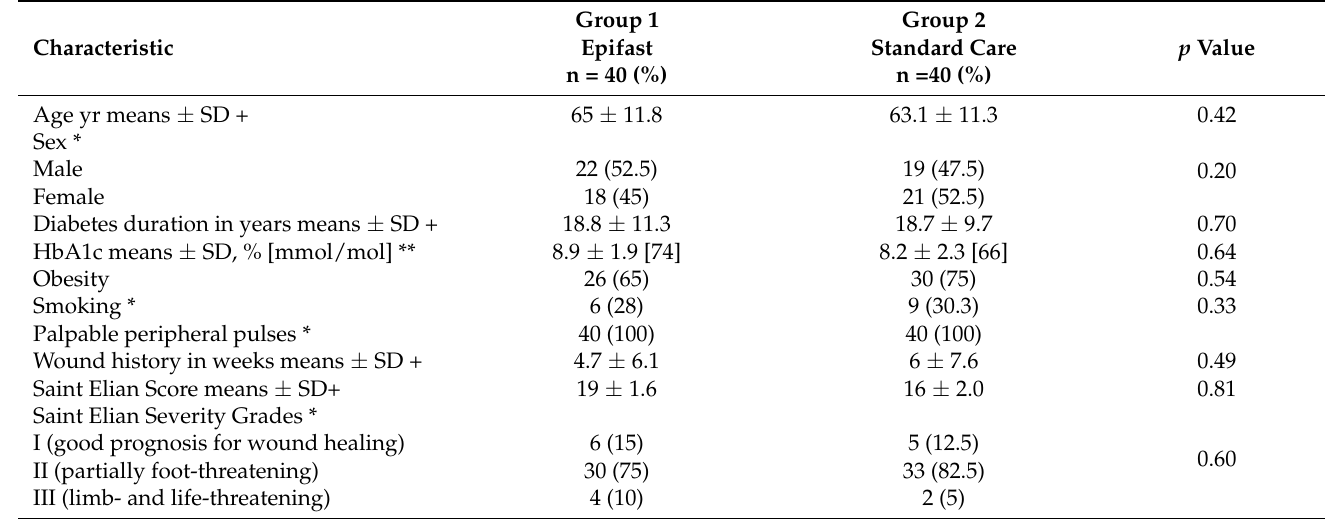
Table 1. Baseline demographic and clinical characteristics.